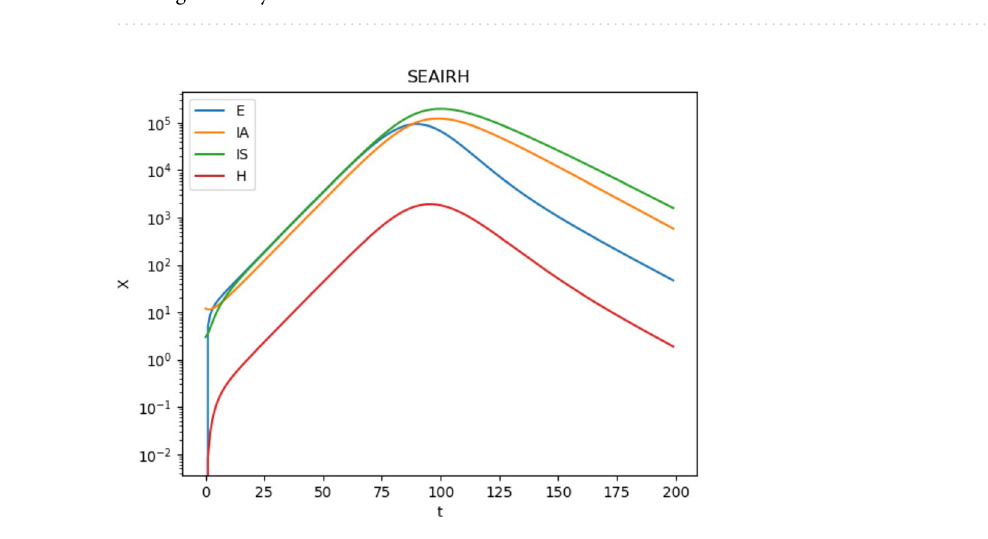
Figure 4. Log-linear plot of rate-limiting variables in the full system of equations integrated